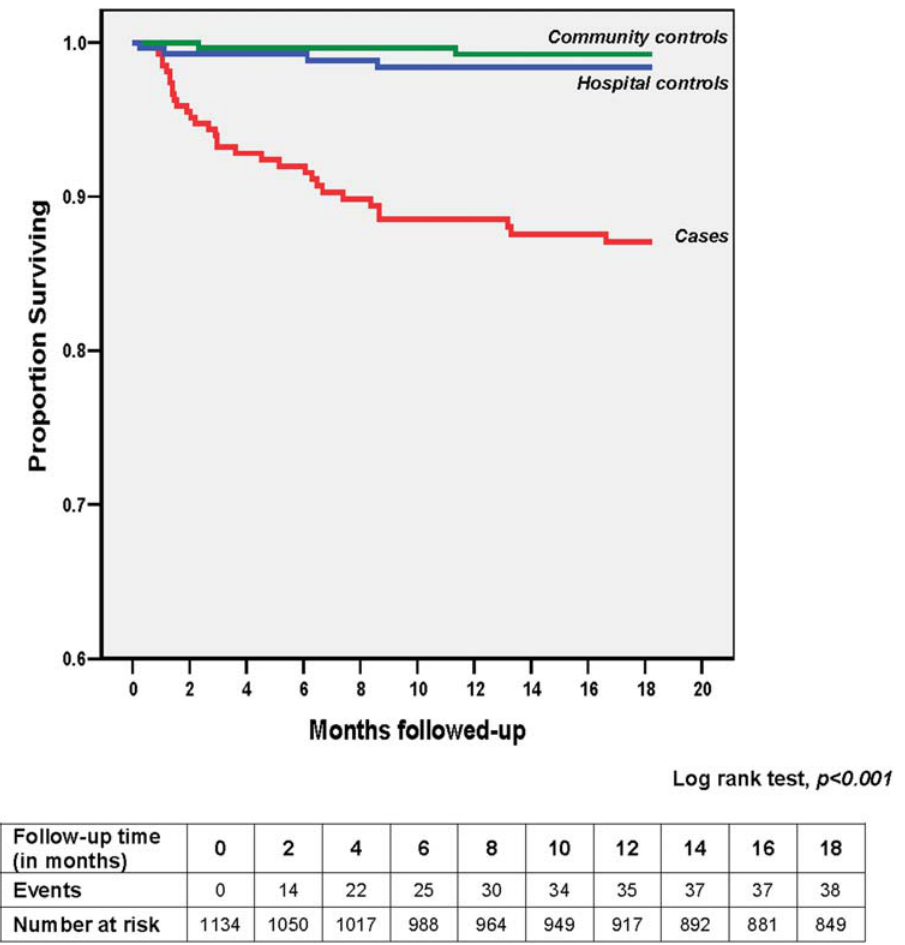
Figure 3. Survival curve showing the time to first severe anaemia episode and the events versus number at risk of severely anaemic children ( cases ) and hospital and community controls during the follow-up period.